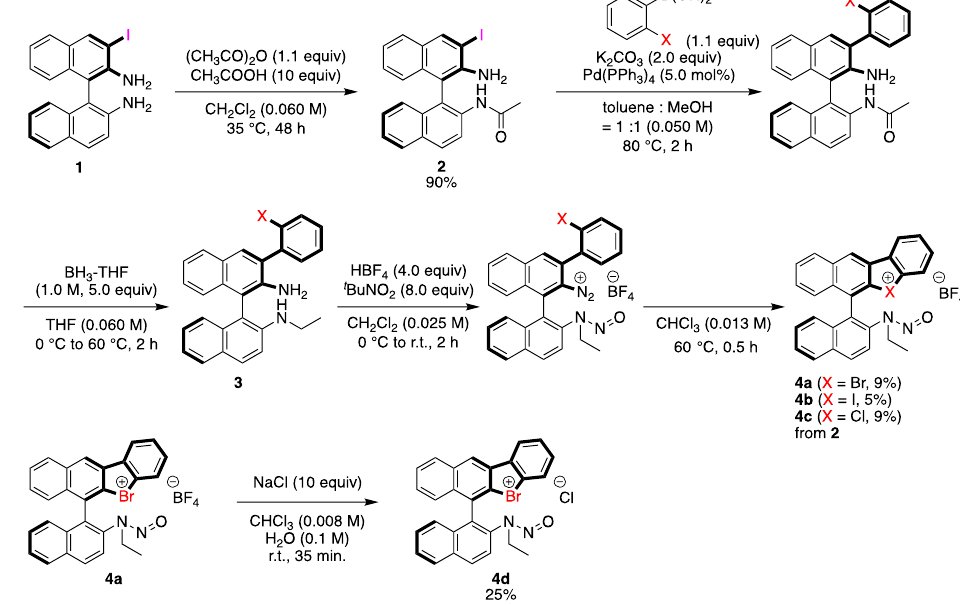
Scheme 1. Synthesis of chiral halonium salts with N -nitrosamine moiety.